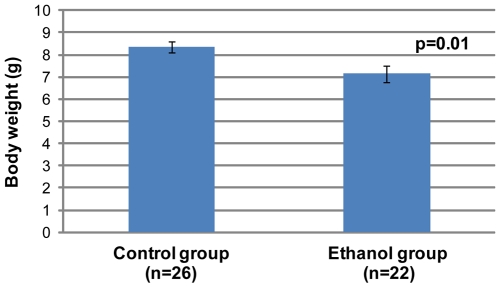
Offspring in the gestational ethanol exposure group have a statistically significantly lower mean weight than the control group (Student's t-test, p<0.05).All were a/a pups from first litters. Pups were weighed at 3 weeks of age and came from litter sizes of 4 and 5. The graph shows mean±SEM.